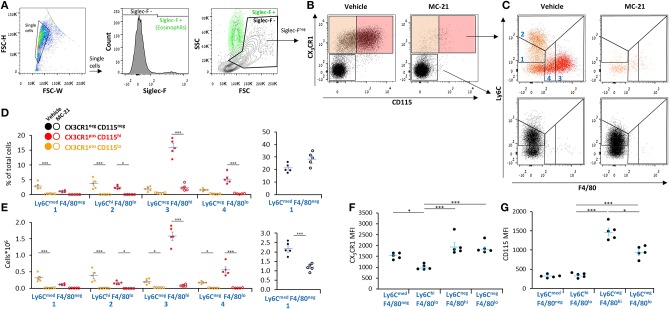
All resolution phase monocytic/macrophage subsets are CCR2-dependent. WT mice undergoing peritonitis were treated I.P. with anti-mouse CCR2 mAb (clone MC-21) or vehicle (control) at peritonitis initiation (0 h) and 24 h PPI. At 72 h, peritoneal cells were collected, immunostained for Ly6C, F4/80, CD115, CX3CR1, and Siglec–F and analyzed by flow cytometry. (A) The gating strategy excluded Siglec-F+ eosinophils (green). (B–D) Samples were analyzed according to CX3CR1 vs. CD115 (B) and CX3CR1+ (top) or CX3CR1− (bottom) cells were analyzed according to F4/80 vs. Ly6C and CD115hi (red dots) vs. CD115lo subsets (C). Analysis of the percentages (D) and cell numbers (E) of the indicated subsets is presented. Results are stacked dot plots (B,C) and means ± SEM (D,E) from n = 5. (F,G) CD115 (F) and CX3CR1 (G) expression by various CX3CR1+ myeloid subsets. Results are means ± SEM of MFI from n = 5. *P < 0.05, ***P < 0.001 (Student's t-test or Tukey's HSD).